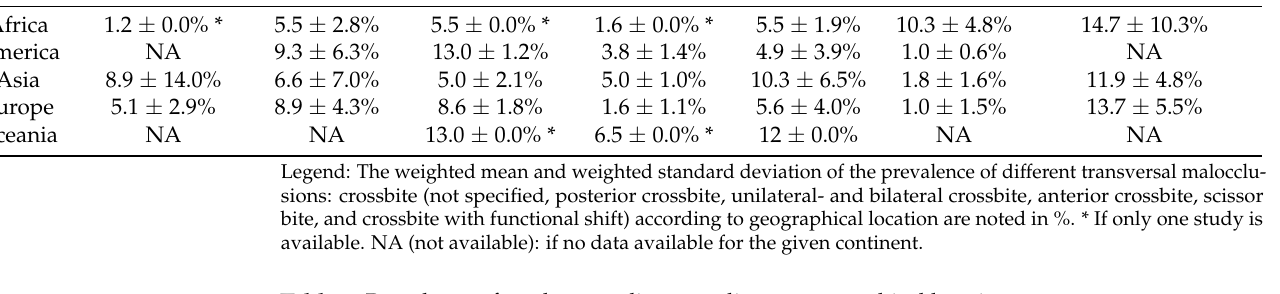
Table 6. Prevalence of tooth anomalies according to geographical location.